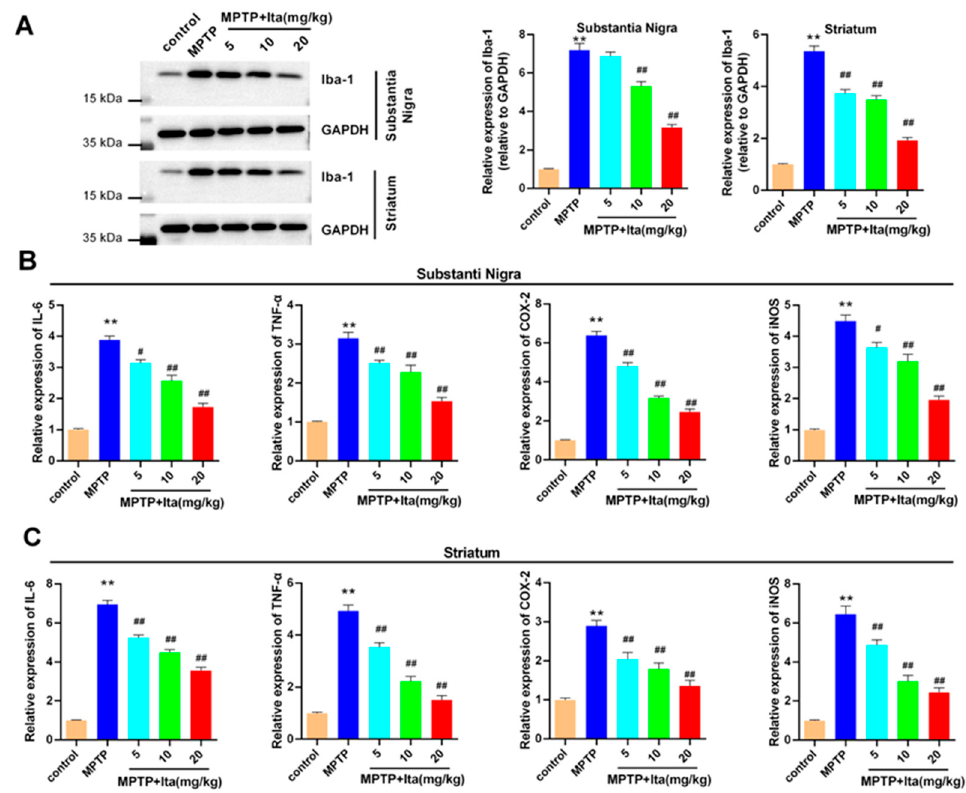
Figure 2. Itaconate attenuated microglia activation and inflammatory response in MPTP-caused PD mice model. ( A ) The expression of Iba-1 levels in substantia nigra and striatum were measured applying Western blotting. GAPDH serves as an internal control. The gene levels of IL-6, TNF- α , COX-2, and iNOS were detected with qRT-PCR in substantia nigra ( B ) and striatum tissues ( C ). n = 5. ** p < 0.01 vs. control group; # p < 0.05, ## p < 0.01 vs. MPTP group. GAPDH, glyceraldehyde-3-phosphate dehydrogenase; Ita, Itaconate.